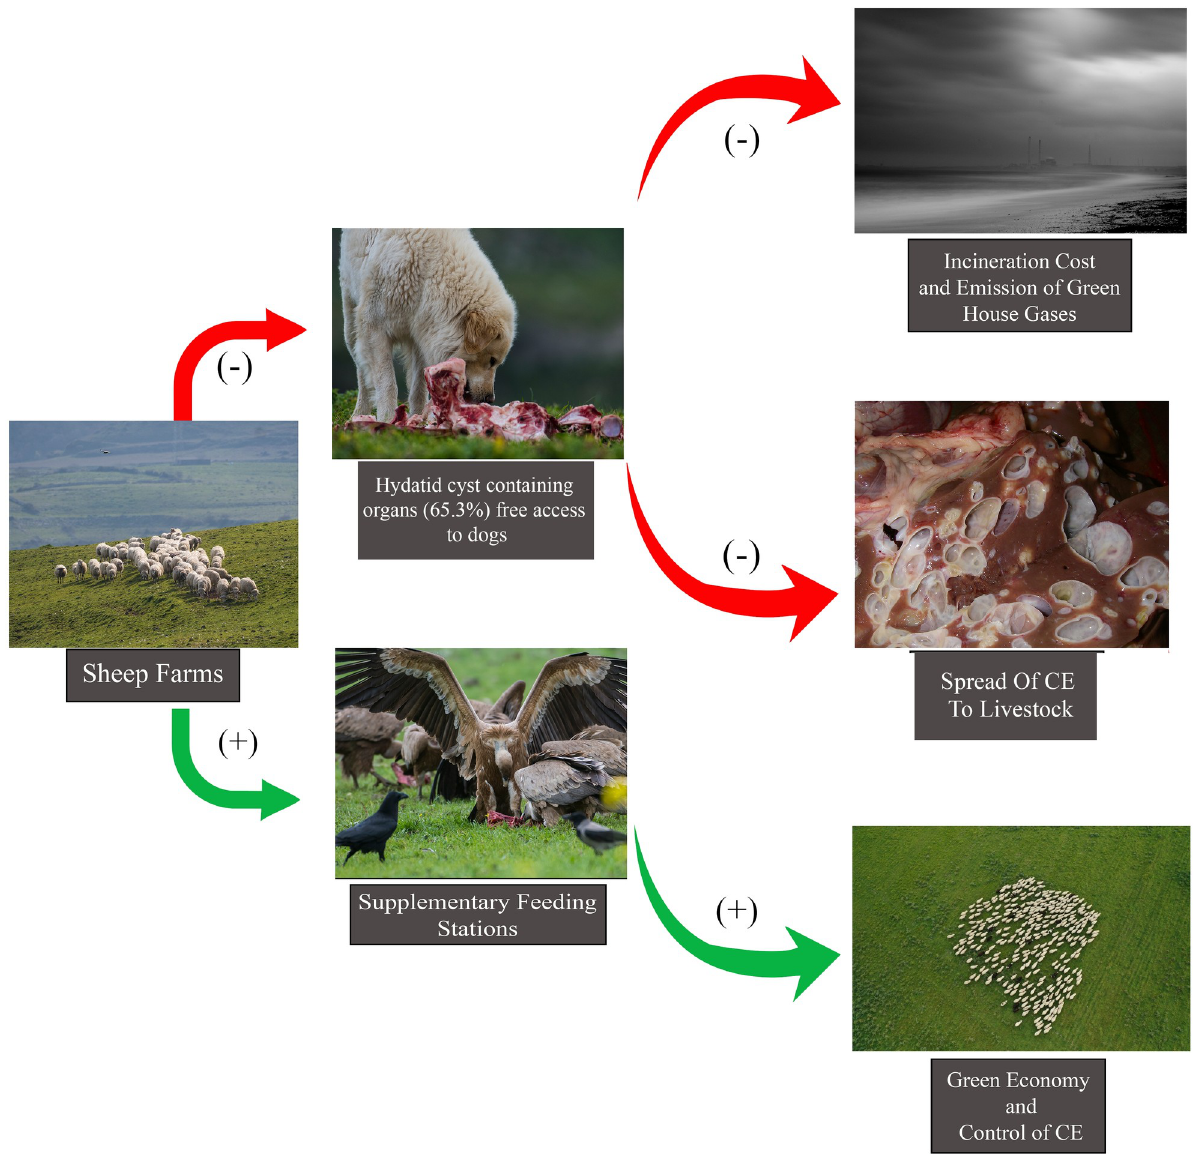
Fig 1. Graphical Abstract. Disruption of CE lifecycle by disposal of carcasses in vultures feeding stations and parallel ecosystem and economic services.